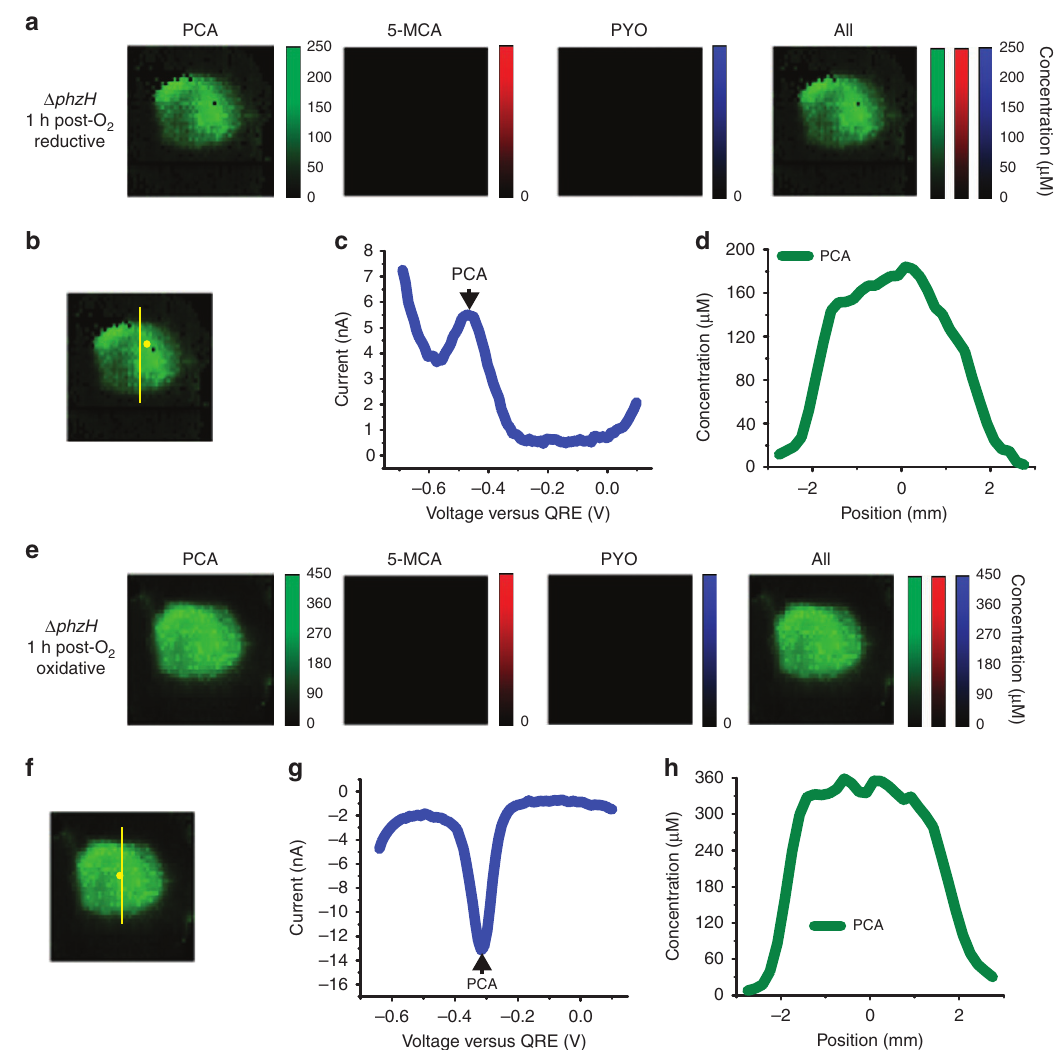
Figure 6 | Electrochemical imaging of an anaerobically grown D phzH biofilm following 1h of oxygenation. ( a ) Electrochemical imaging, based on reductive SWV, of a D phzH biofilm, after 2 days of anaerobic development and after 1h of subsequent exposure to O 2 . Pixel intensity is proportional to phenazine concentration. PCA is shown in green. Maximum error due to electrode variability is 28 m M for PCA. Images are 8mm (cid:2) 8mm. ( b ) Locations of example square-wave voltammogram and cross-section in c , d , respectively. ( c ) Example square-wave voltammogram from a single electrode. ( d ) Example cross-section from the electrochemical image in a . ( e ) Electrochemical imaging, based on oxidative SWV, of the same D phzH biofilm shown in a . Pixel intensity is proportional to phenazine concentration. PCA is shown in green. Maximum error due to electrode variability is 74 m M for PCA. Images are 8mm (cid:2) 8mm. ( f ) Locations of example square-wave voltammogram and cross-section in g , h , respectively. ( g ) Example